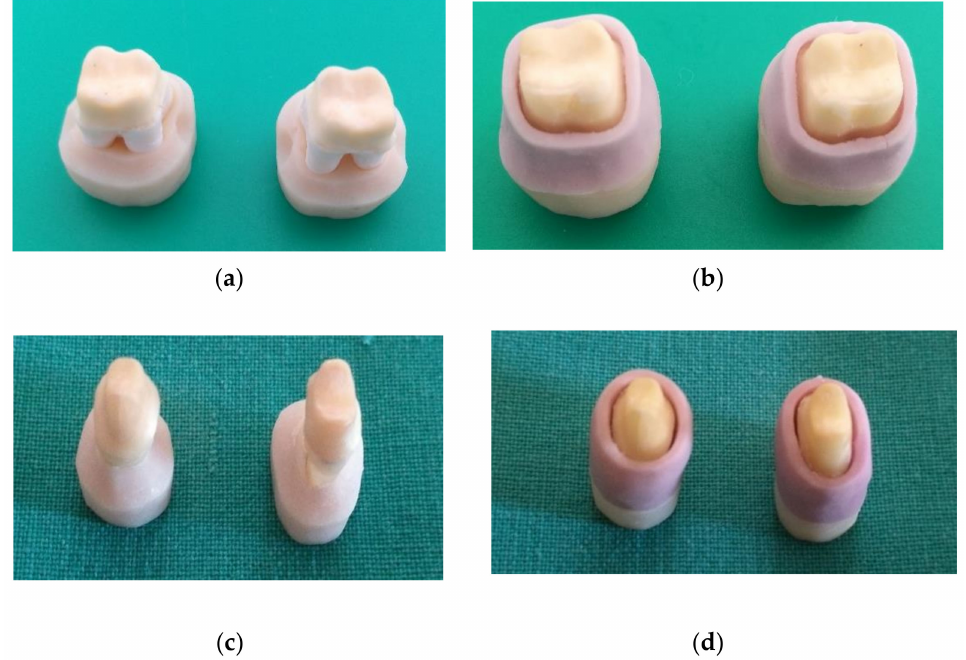
Figure 3. Samples during the construction phases of the base: ( a ) a base of the incorporated root portion of molar element; ( b ) A model of elastomer gel simulating human sulci and clinical gingival conditions; ( c ) a base of the incorporated root portion of premolar element; ( d ) A model of elastomer gel simulating human sulci and clinical gingival